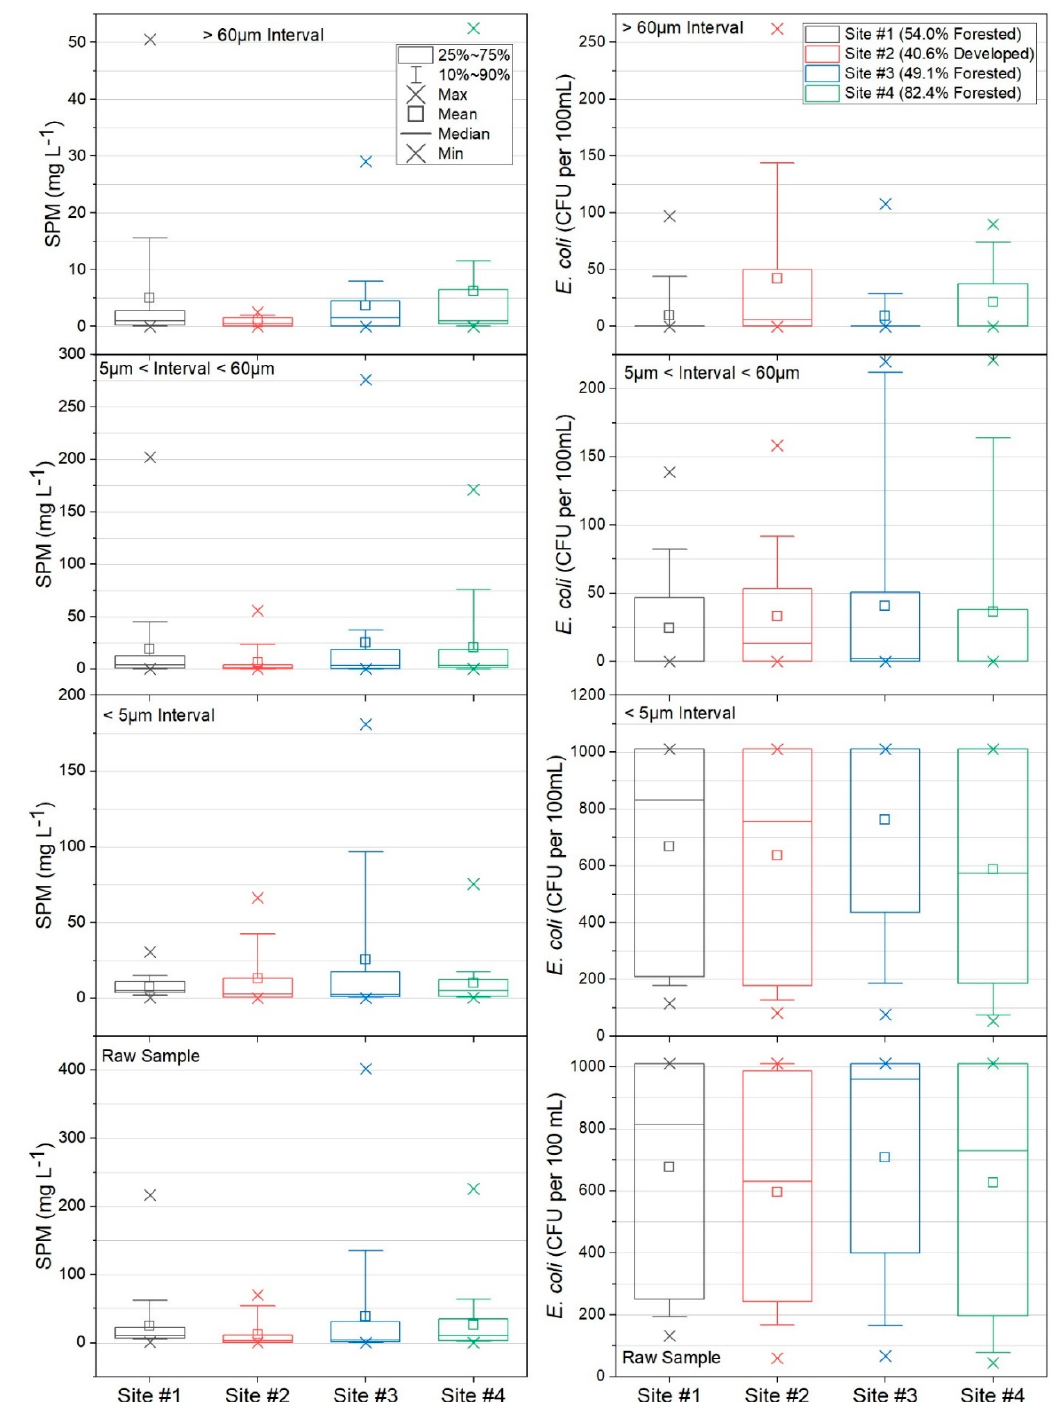
Figure 3. Box and whisker plot of suspended particulate matter (SPM) (mg L − 1 ) and E. coli concentration (CFU per 100 mL) at each sampling location (n = 4) during the study period (20 July 2018–27 October 2018) in West Run Watershed, Morgantown, West Virginia, USA. Box delineates 25th and 75th percentiles; line denotes median; square shows mean; whisker describes 10th and 90th percentiles; x shows maximum and minimum when above and below, respectively.